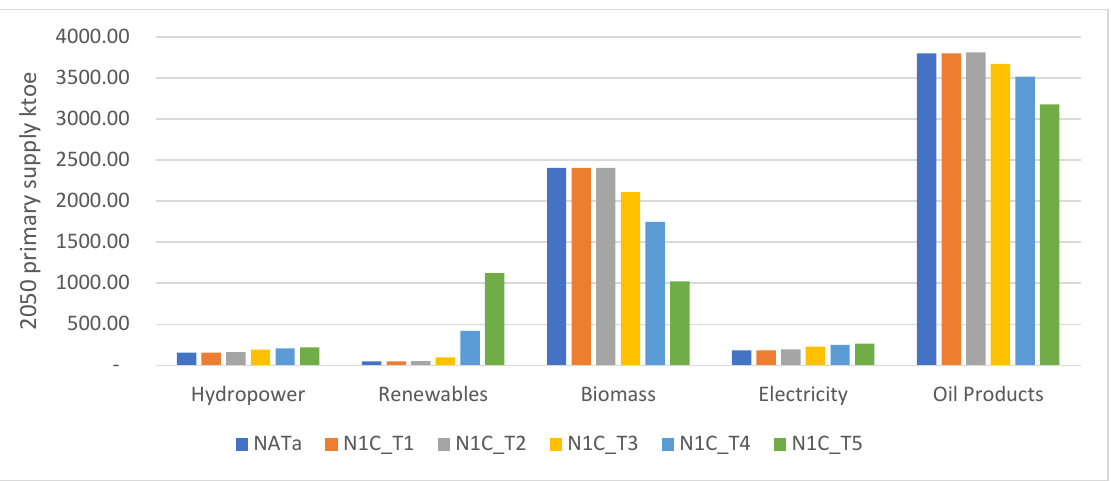
Figure 6. Energy supply by 2050 for scenarios based on NATa.